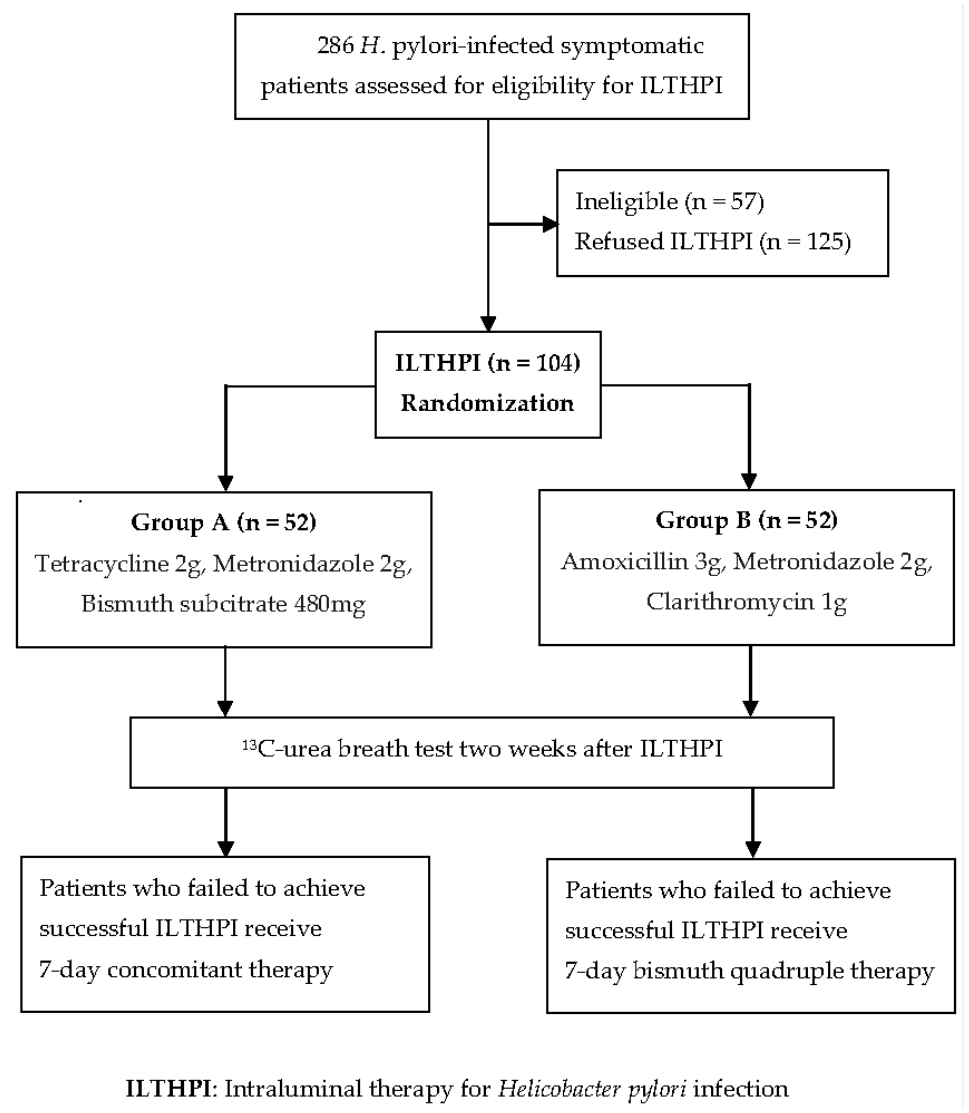
Figure 1. Study fl ow chart. Figure 1. Study flow